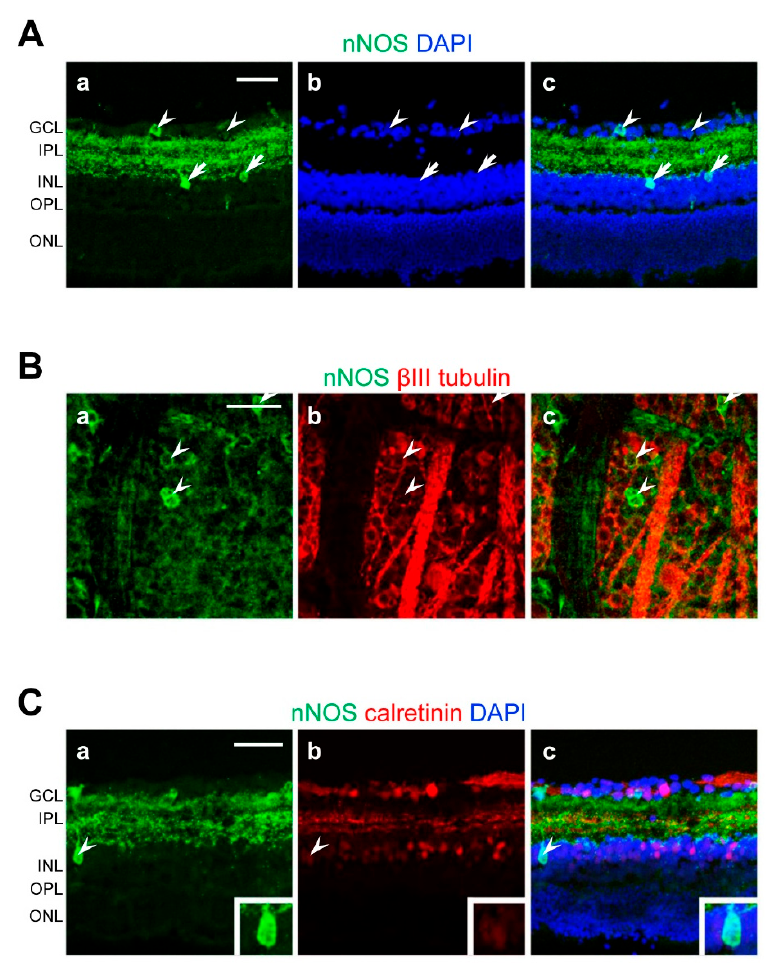
Figure 3. Localization of immunoreactivities of neuronal NO synthase (nNOS) in the retina. Confocal microscopy images of retinal flat-mounts and cross-sections labeled with anti-nNOS, anti- β III-tubulin, or anti-calretinin antibodies. ( A ) Distribution of nNOS immunoreactivities. ( a – c ) Arrowheads and arrows indicate nNOS-positive cells in the ganglion cell layer (GCL) and inner plexiform layer (INL), respectively. ( B ) Co-localization of nNOS immunoreactivities with β III-tubulin-positive ganglion cells. ( a – c ) Arrowheads indicate nNOS- and β III-tubulin-double positive cells. ( C ) Co-localization of nNOS immunoreactivities with calretinin-positive amacrine cells. ( a – c ) Arrowheads indicate calretinin-positive amacrine cells with strong nNOS immunoreactivity. A higher magnification image of the cell is shown in the inset. Scale bars: ( A – C ) 50 μ m in a (applies to b , c ). DAPI, 4 ′ ,6-diamidino-2-phenylindole; IPL, inner plexiform layer; OPL, outer plexiform layer; ONL, outer nuclear layer.